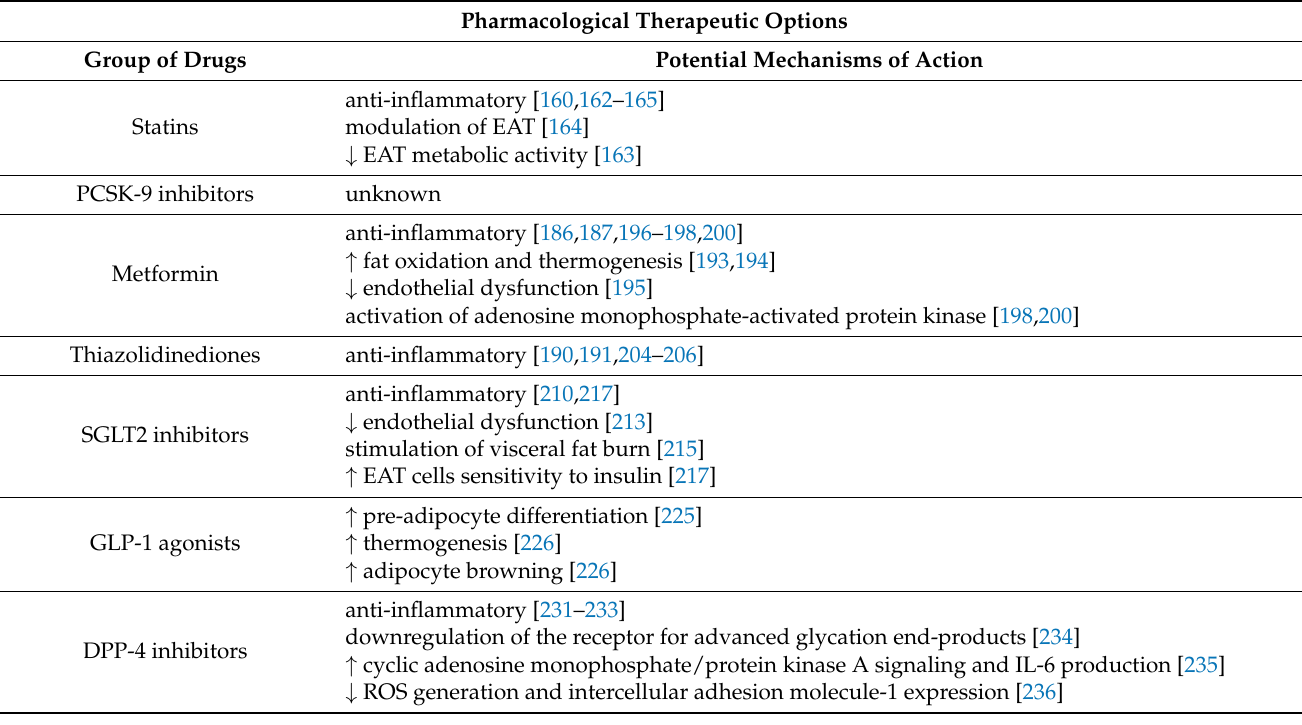
Table 1. Pharmacological therapeutic options to affect epicardial adipose